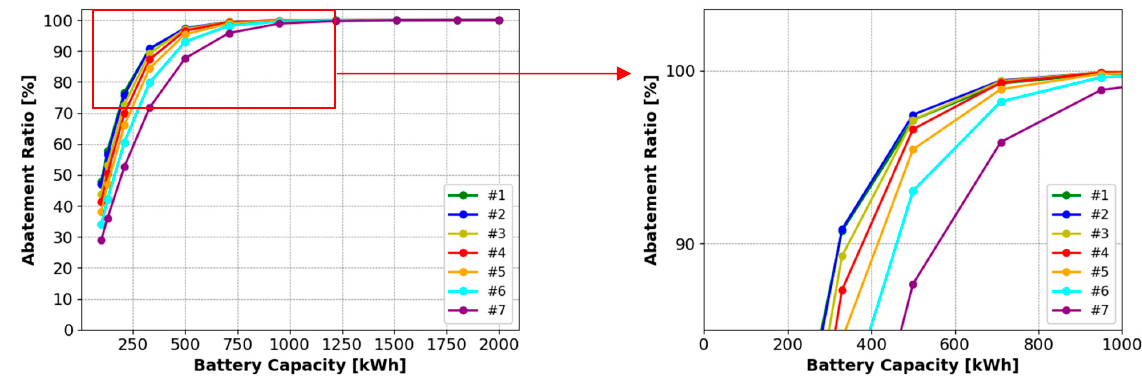
Figure 13. Abatement Ratio vs. Battery Capacity: comparison for different wavelet levels.